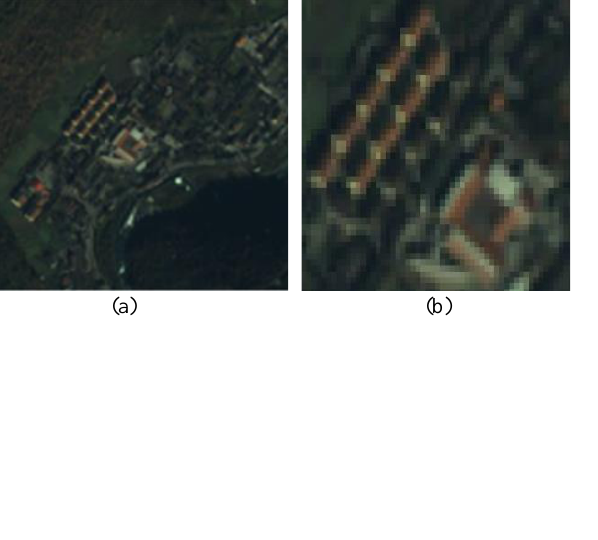
Figure1. (a) The result of pMRI reconstruction, (b)ASDS, (c) Generative Bayesian, (d) Tensor Sparsity, (e) FISTA, (f) Incremental DL, (g) Bicubic, (h) Proposed Method